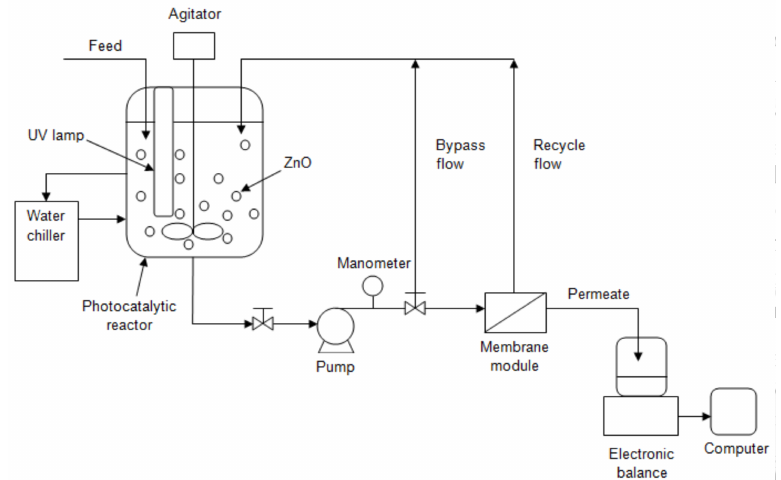
Figure 11. Schematic diagram of the PMR coupled with NF for removal of Congo Red. [32].